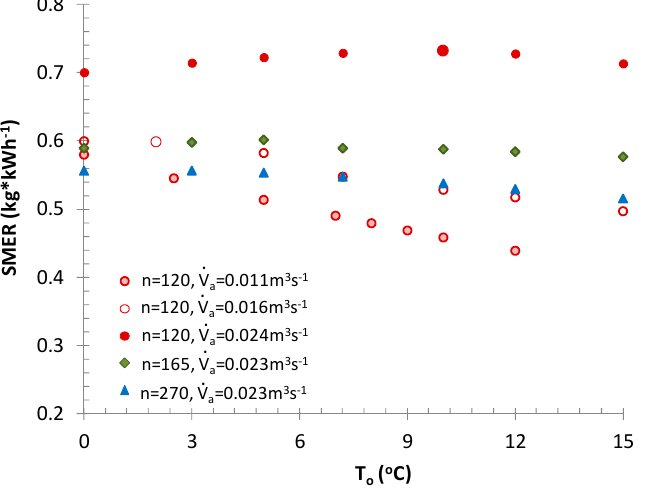
(cid:16) (cid:17) . T o , n , V a